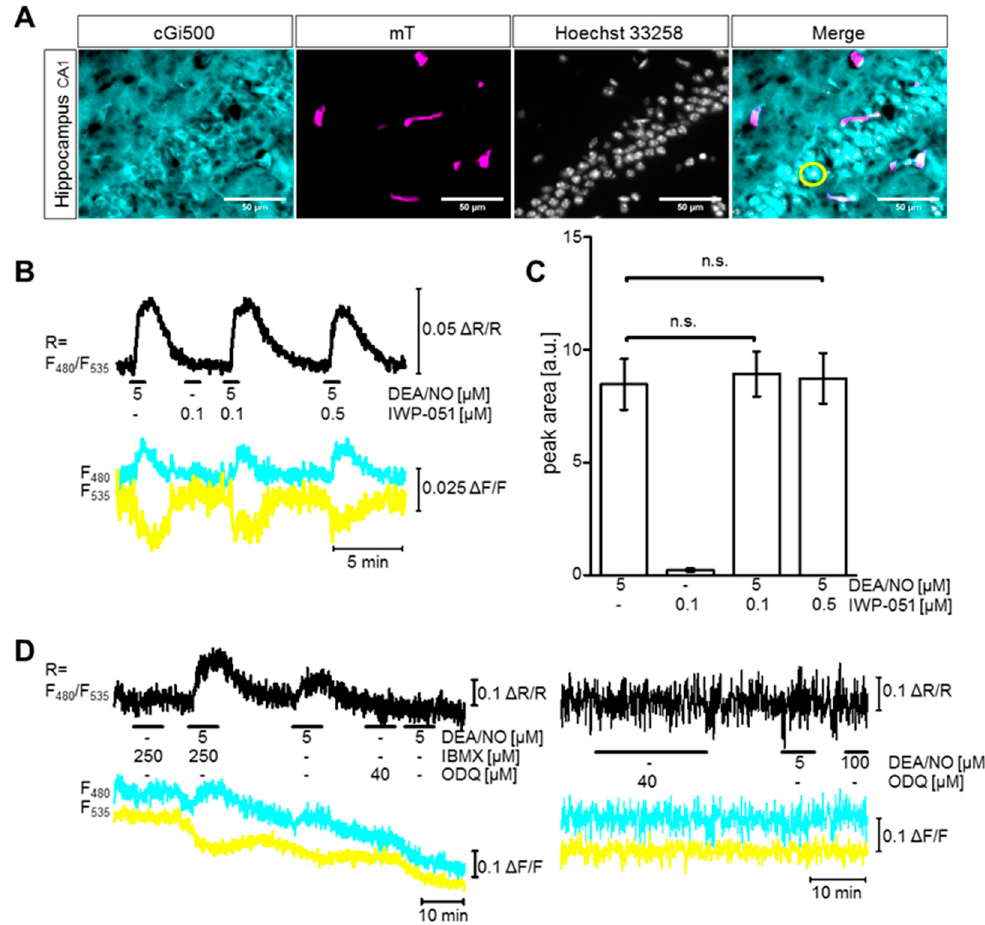
Figure 3. IWP-051 does not potentiate DEA/NO-induced cGMP signals in the hippocampal CA1 area. ( A ) Representative pictures of the hippocampal CA1 area in fixed NesCre;R26-CAG-cGi500(L2) brain sections showing expression of cGi500 (cyan) and membrane-targeted tomato protein (mT, magenta), staining of nuclei with Hoechst (grey), and an overlay of all three channels (Merge). The yellow circle shows a representative ROI chosen for analysis; ( B – D ) cGMP imaging of hippocampal cells in the CA1 region was performed in acute hippocampal brain slices from NesCre;R26-CAG-cGi500(L2) mice. To avoid false-positive signals, only regions of interest that were separated from surrounding blood vessels were analyzed (e.g., yellow circle in panel ( A )). Black, cyan and yellow traces represent CFP/YFP ratio, CFP and YFP, respectively; ( B ) Representative experiment in which DEA/NO and IWP-051 were applied in the indicated concentrations (black horizontal lines) and ( C ) statistical analysis of peak areas of respective cGMP signals; data are shown as mean ± SEM ( n = 9 ROIs from three brain slices); n.s., not significant. Similar results were obtained in independent experiments with additional mice and brain slices (see Figure 6B,D, wildtype). ( D ) Representative experiments in which 3-isobutyl-1-methylxanthin (IBMX) and 1H-[1,2,4]oxadiazolo[4 ,3-a]quinoxalin-1-one (ODQ) were applied before or in combination with DEA/NO application. The respective concentrations are indicated in the graphs. Similar results were obtained in at least three ROIs measured on two brain slices (IBMX and ODQ, left) or one brain slice (ODQ, right).